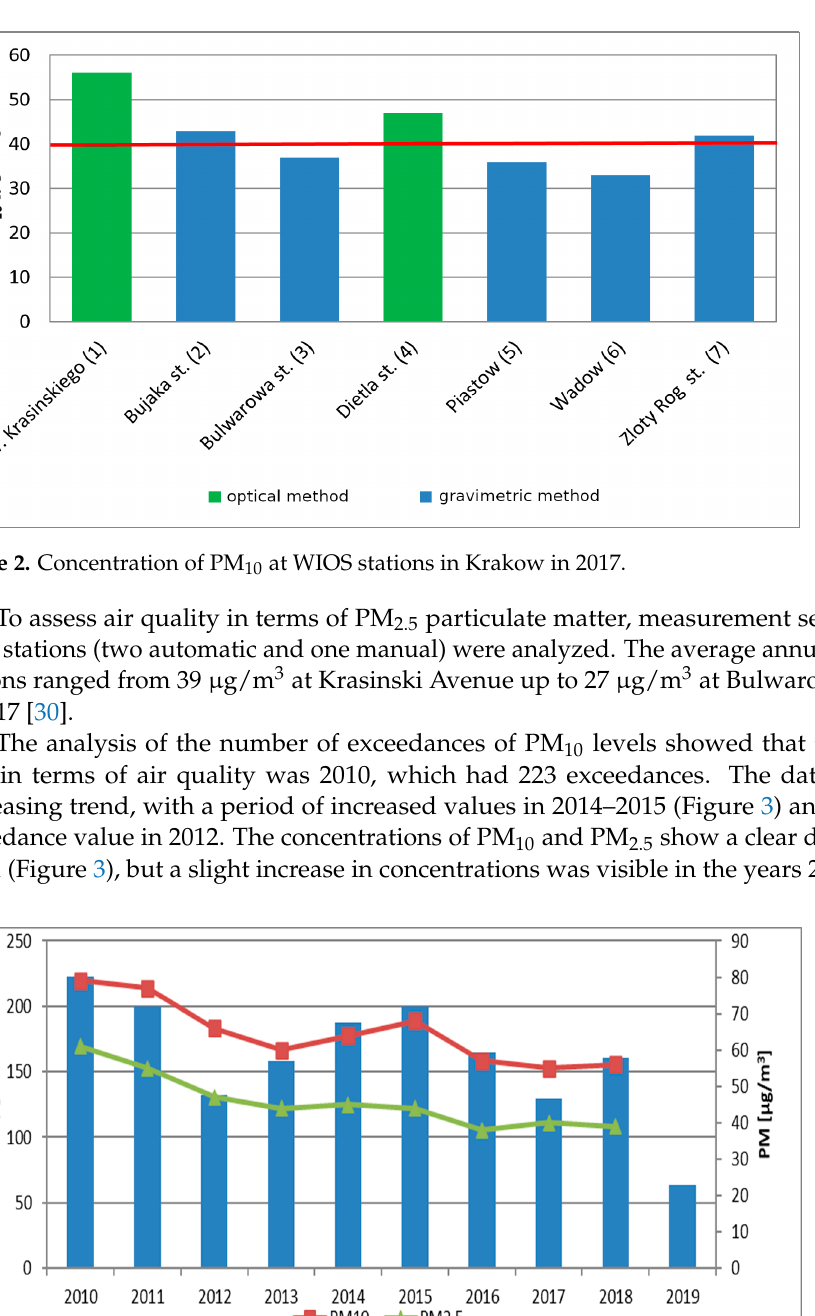
Figure 1. WIOS air quality station locations in Krakow.